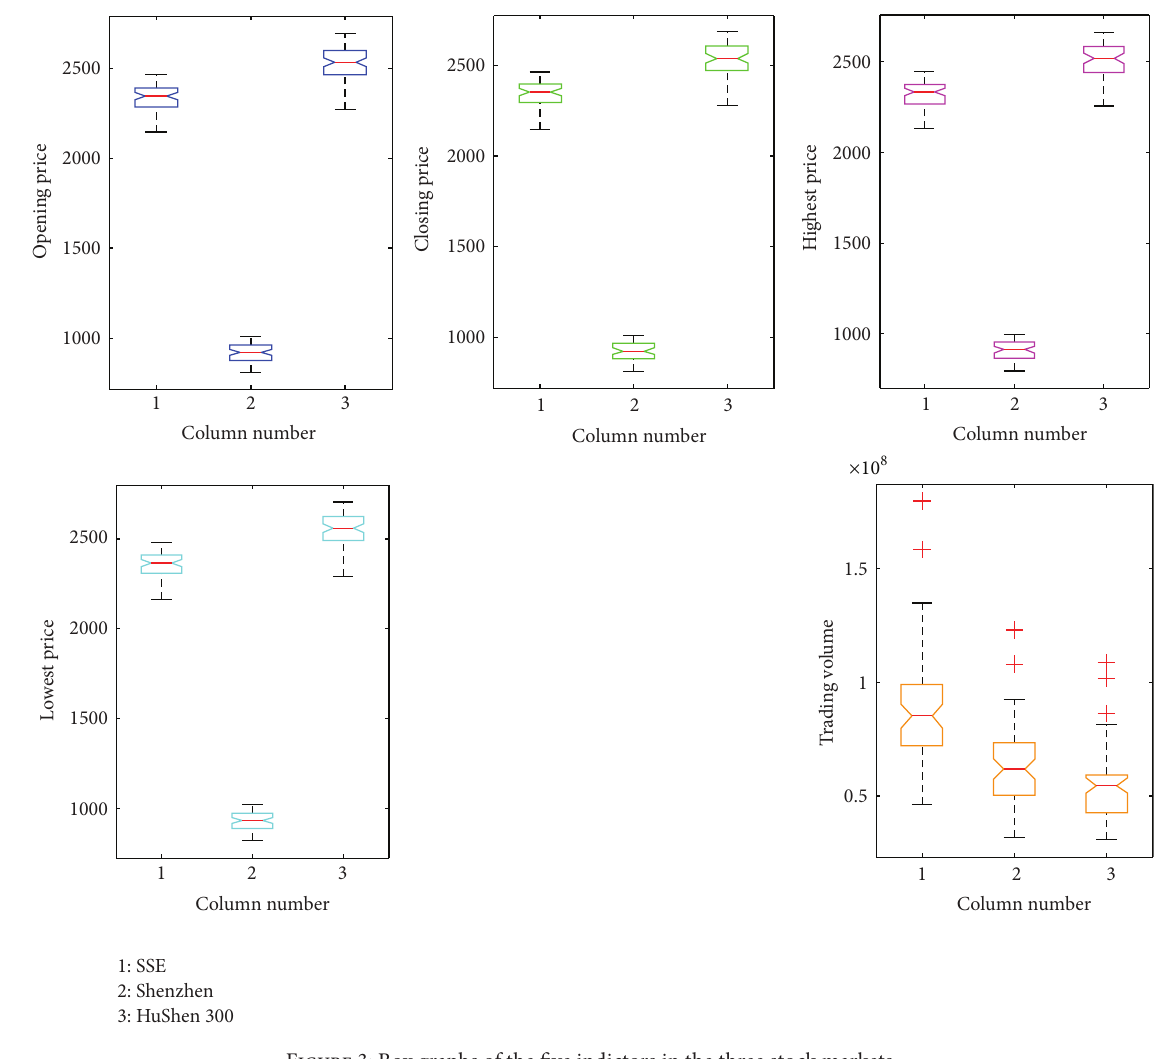
Figure 3: Box graphs of the five indictors in the three stock markets.